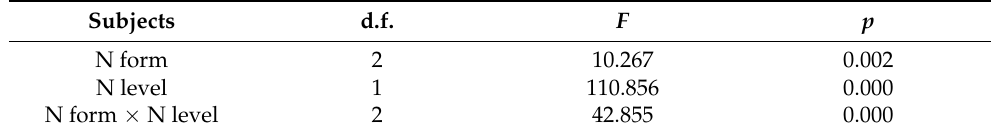
Table 4. Results of one-way ANOVA and LSD test on the effects of time, N form and level, and their interactions on cumulative DOC